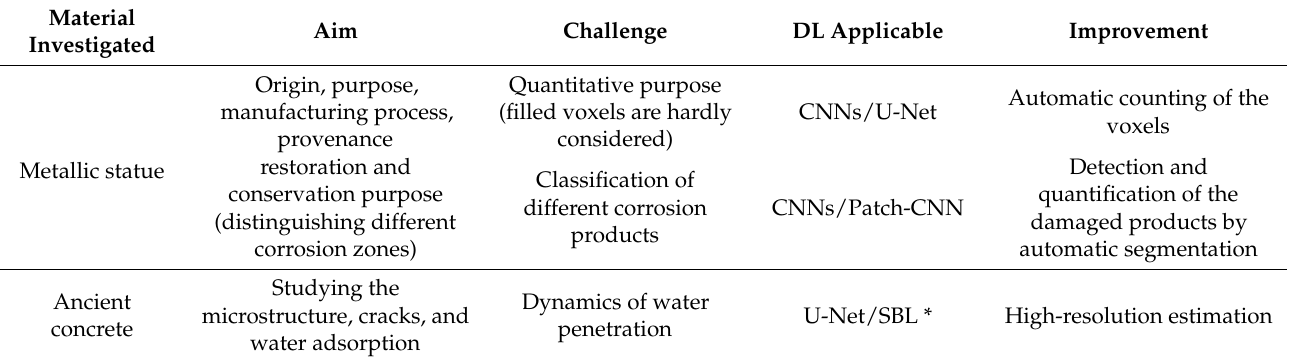
Table 5. NT and NR in cultural heritage and the improvements obtained via DL